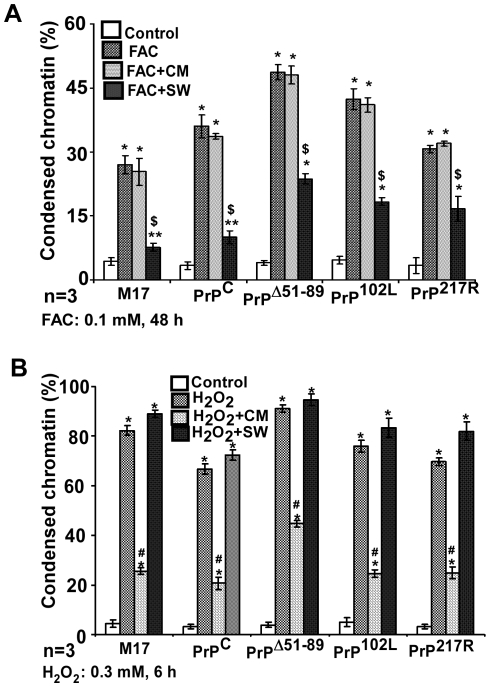
FAC induced toxicity is through PrP-ferritin aggregates.(A) Quantification of FAC induced cell death in M17, PrPC and mutant cell lines PrPΔ51–89, PrPP102L, and PrP217R when cultured in the presence of SW CM or co-cultured with SW cells shows significant toxicity by FAC in all cell lines, minimal protective effect of CM, and significant rescue by co-culture with SW cells. *p<0.001; **p<0.01 as compared to untreated controls; $
p<0.001 as compared to FAC and FAC+CM treated cells. (B) Exposure of the same cell lines to H2O2 induces death in all cell lines as expected, and significant rescue by SW CM. Co-culture with SW cells has no measurable effect. *p<0.001 as compared to untreated controls; #
p<0.001 as compared H2O2, H2O2+SW treated cells.